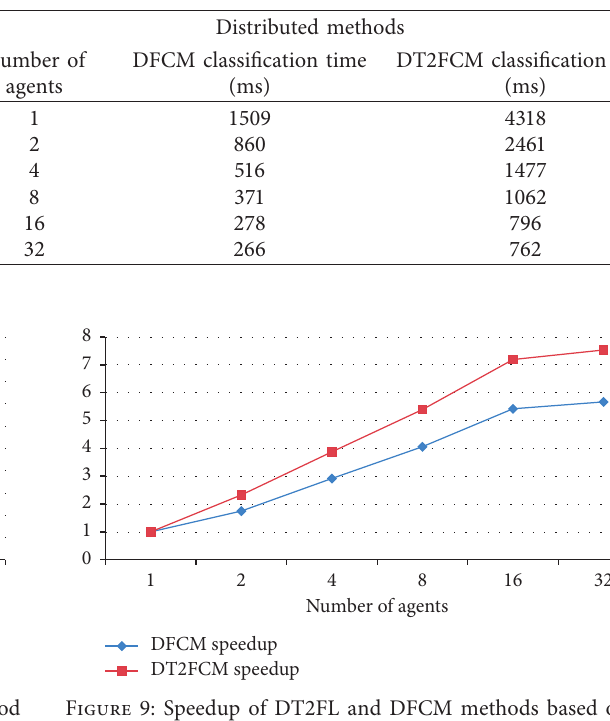
Figure 7: Dynamic convergence of class centers starting from class centers (c1, c2, c3, c4, c5) � (140.5, 149.5, 150.5, 220.2, 250.5). (a) Class centers and (b) error. Table 2: Comparing metric classification time of standard methods and distributed